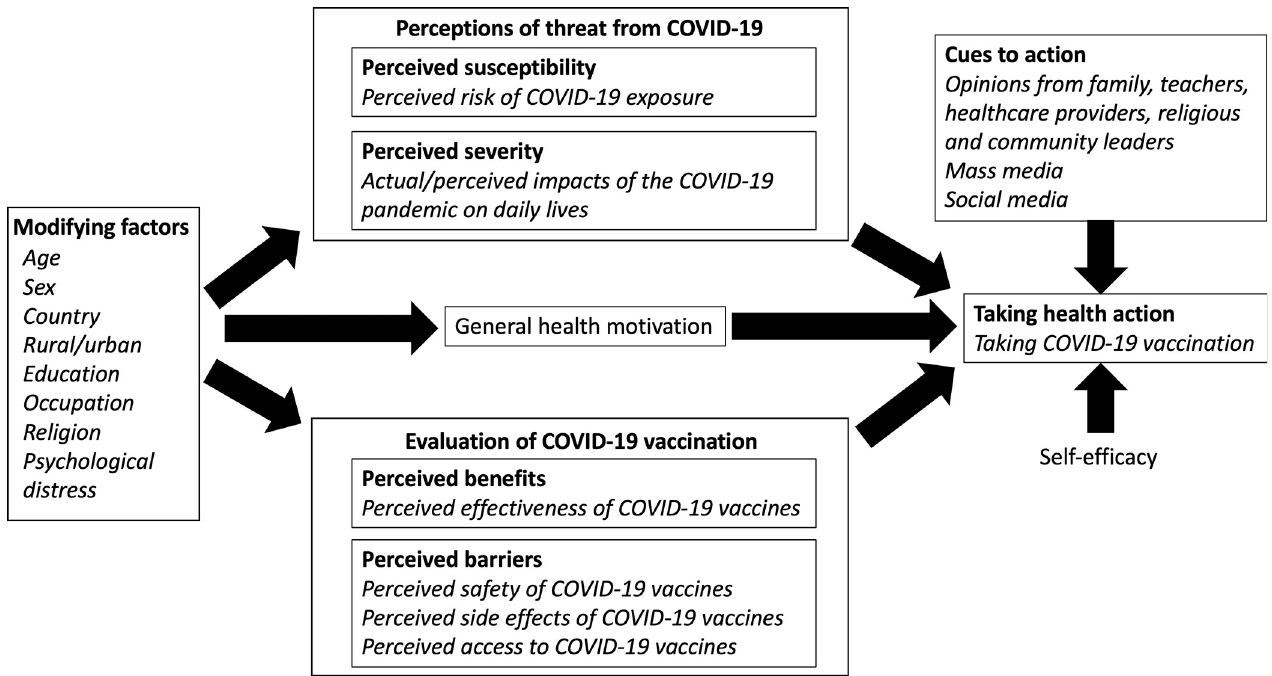
Fig 1. Conceptual framework for COVID-19 hesitancy among adolescents based on the health belief model.